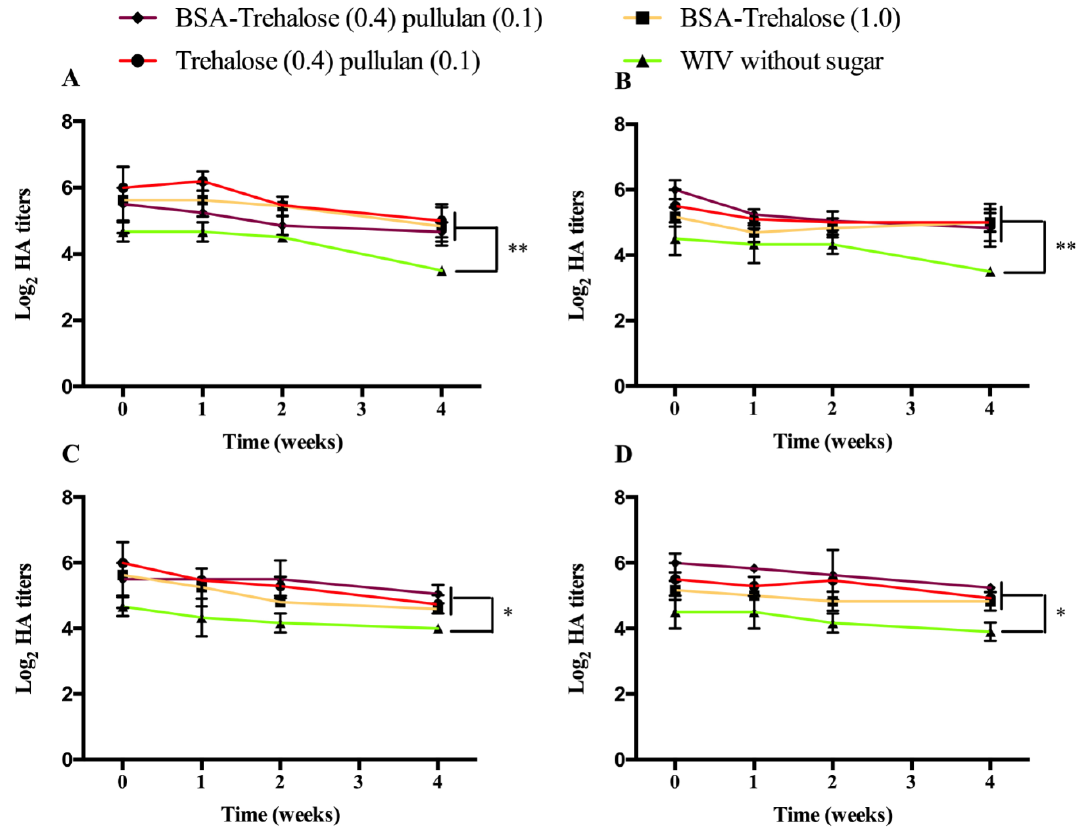
Figure 2. Process and storage stability of WIV incorporated in air- ( A and C ) and vacuum-dried ( B and D ) ODFs up to 4 weeks at 60 °C/0% RH ( A and B ) or 30 °C/56% RH ( C and D ). Hemagglutination titers are represented as log 2 titers with significance indicated as * p < 0.05 and ** p <